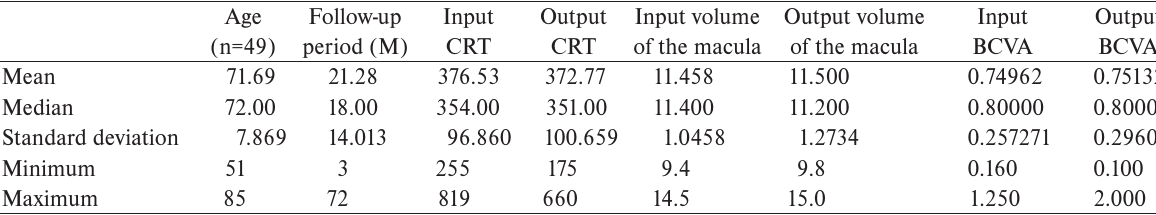
Table 2. Preoperative and postoperative parameters of 53